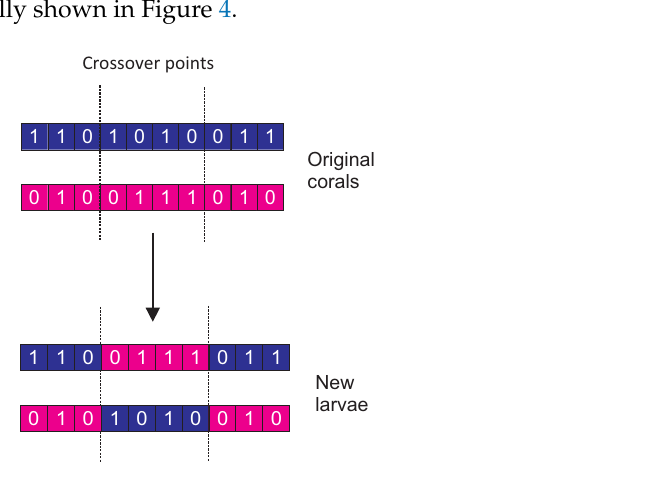
Figure 4. An illustration of the CRO broadcast scheduling process used to generate new larvae using the two-point crossover (2PX)